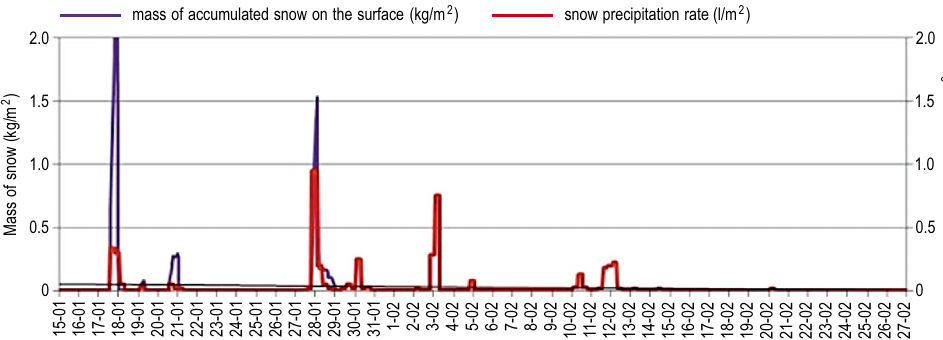
Fig. 8. Predicted mass of accumulated snow on the surface with the snow precipitation